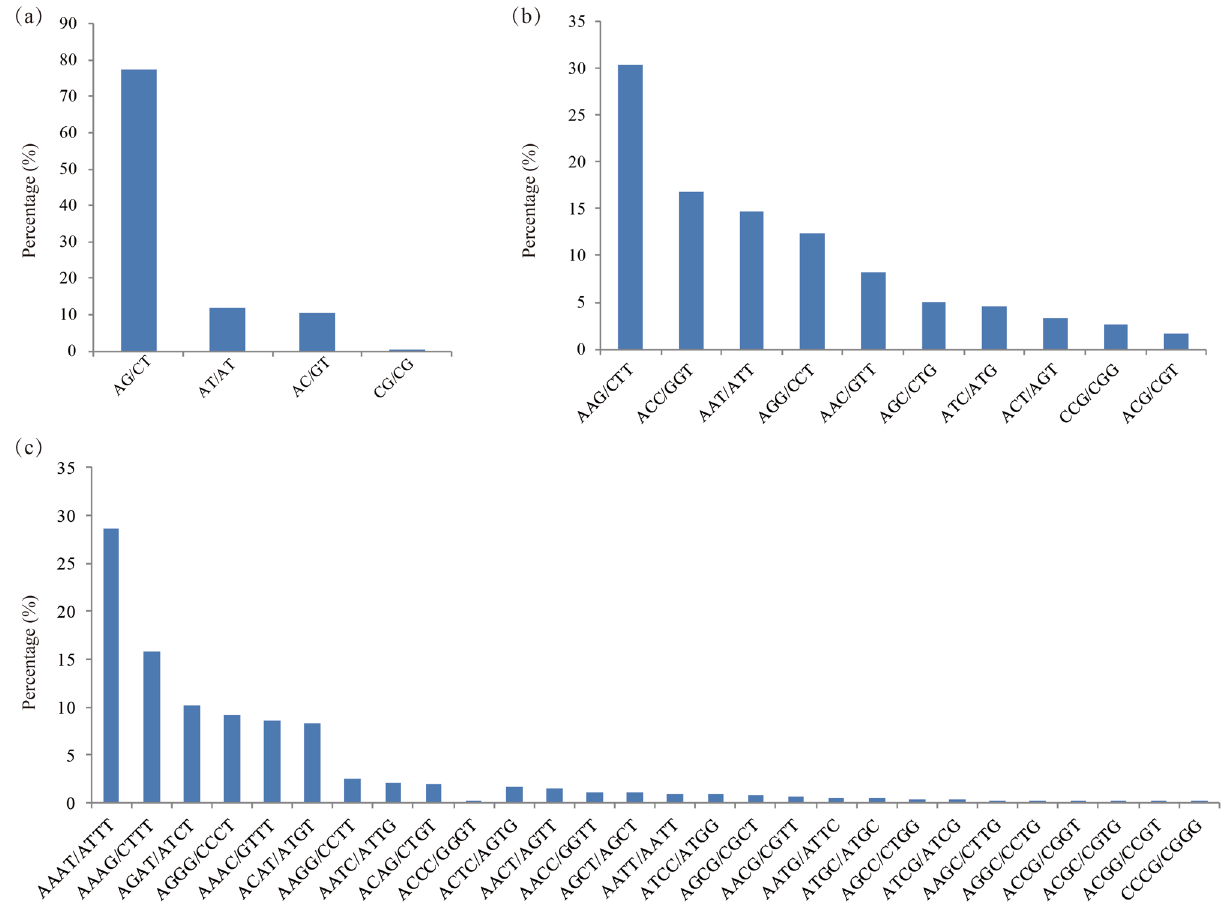
Figure 1. Frequency of consensus sequences containing di-nucleotide ( a ), tri-nucleotide ( b ) and tetra- nucleotides ( c ) motifs in R. dauricum and R. mucronulatum